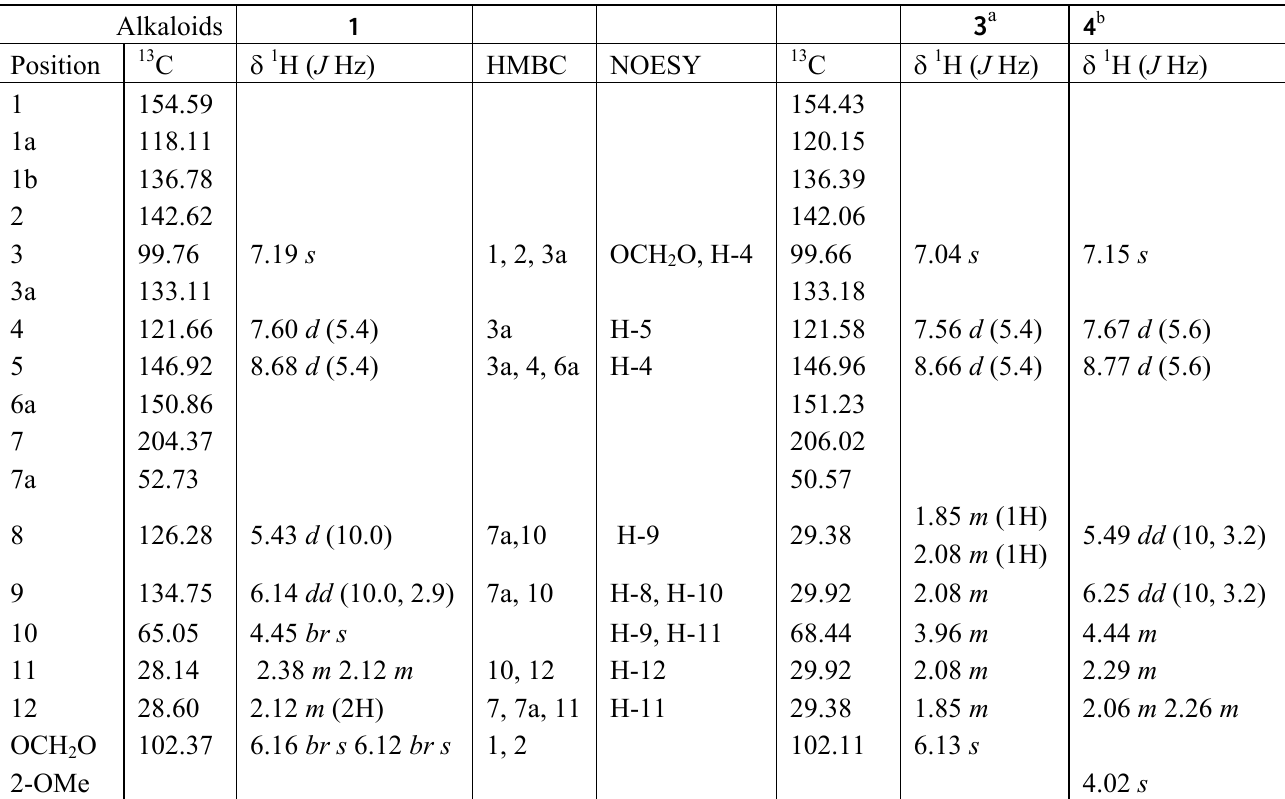
Table 1 . 1 H-NMR (400 MHz) and 13 C-NMR (100 MHz) spectral data of compounds 1, 3 and 4 in CDCl ( δ in ppm, J in Hz) 3